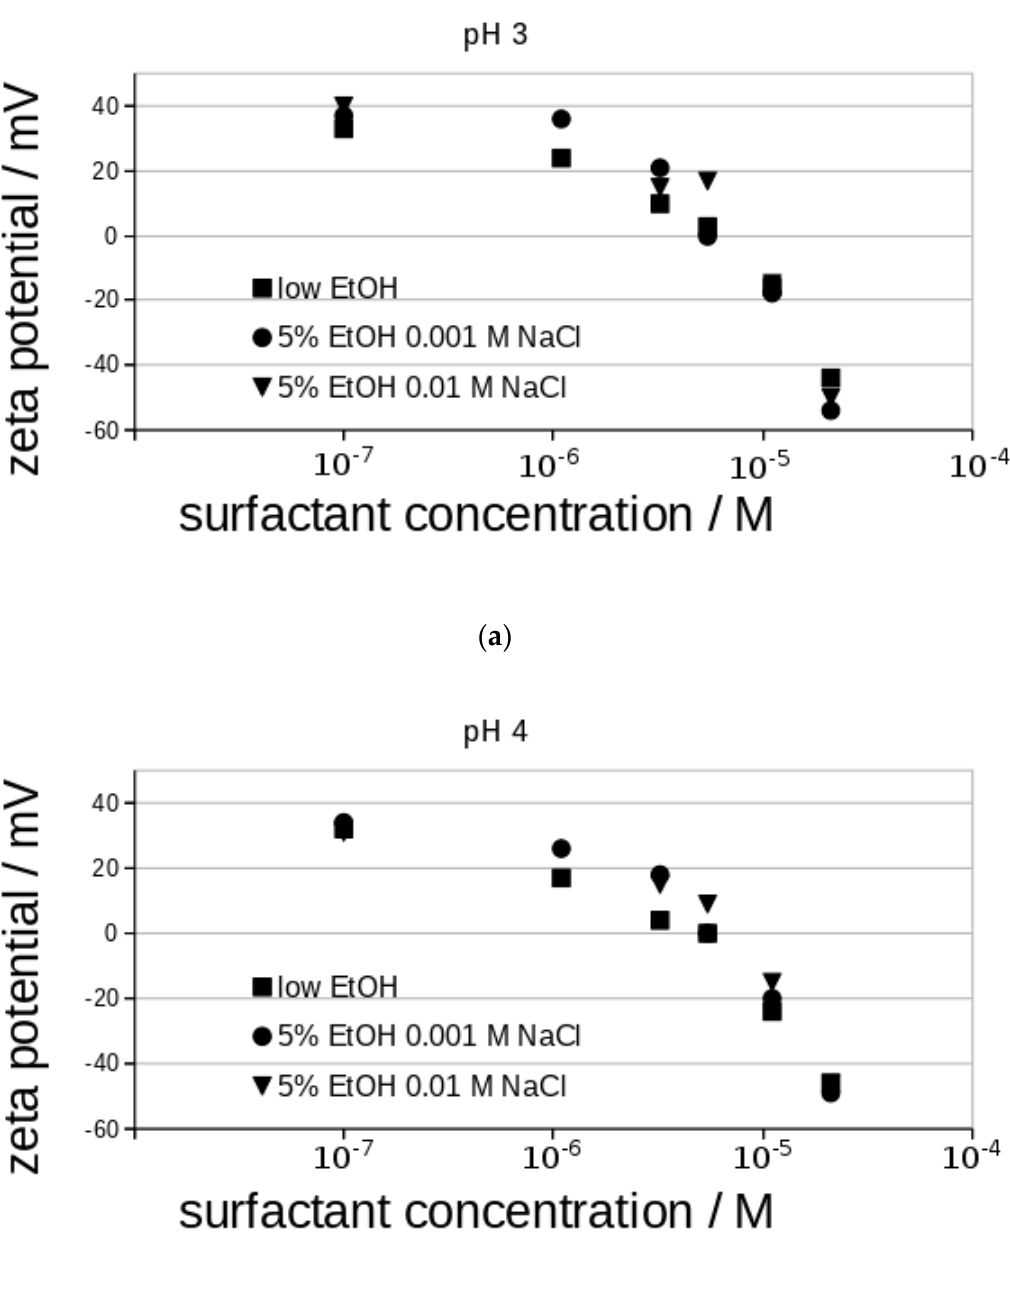
Figure 3. The zeta potentials of titania at pH 3 ( a ) and 4 ( b ) interpolated from the results shown in Figures 1 and 2 at various concentrations of NaCl and of ethanol.